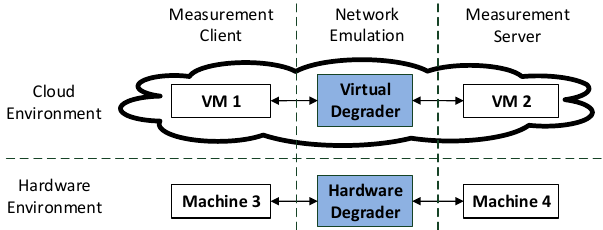
Figure 3: Environments for measuring the accu- racy of the network emulation in the Cloud-